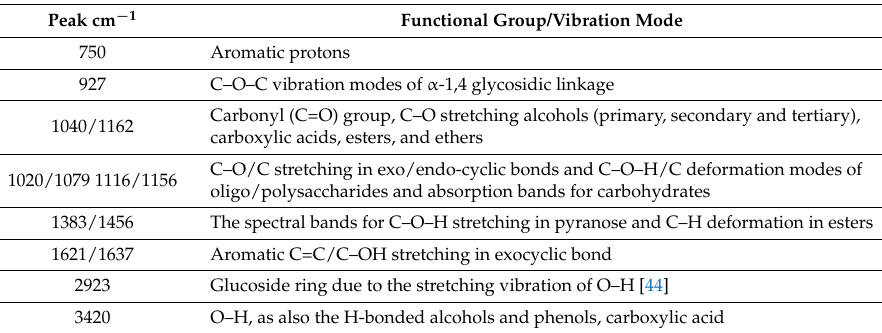
Table 3. Description of FTIR peaks.